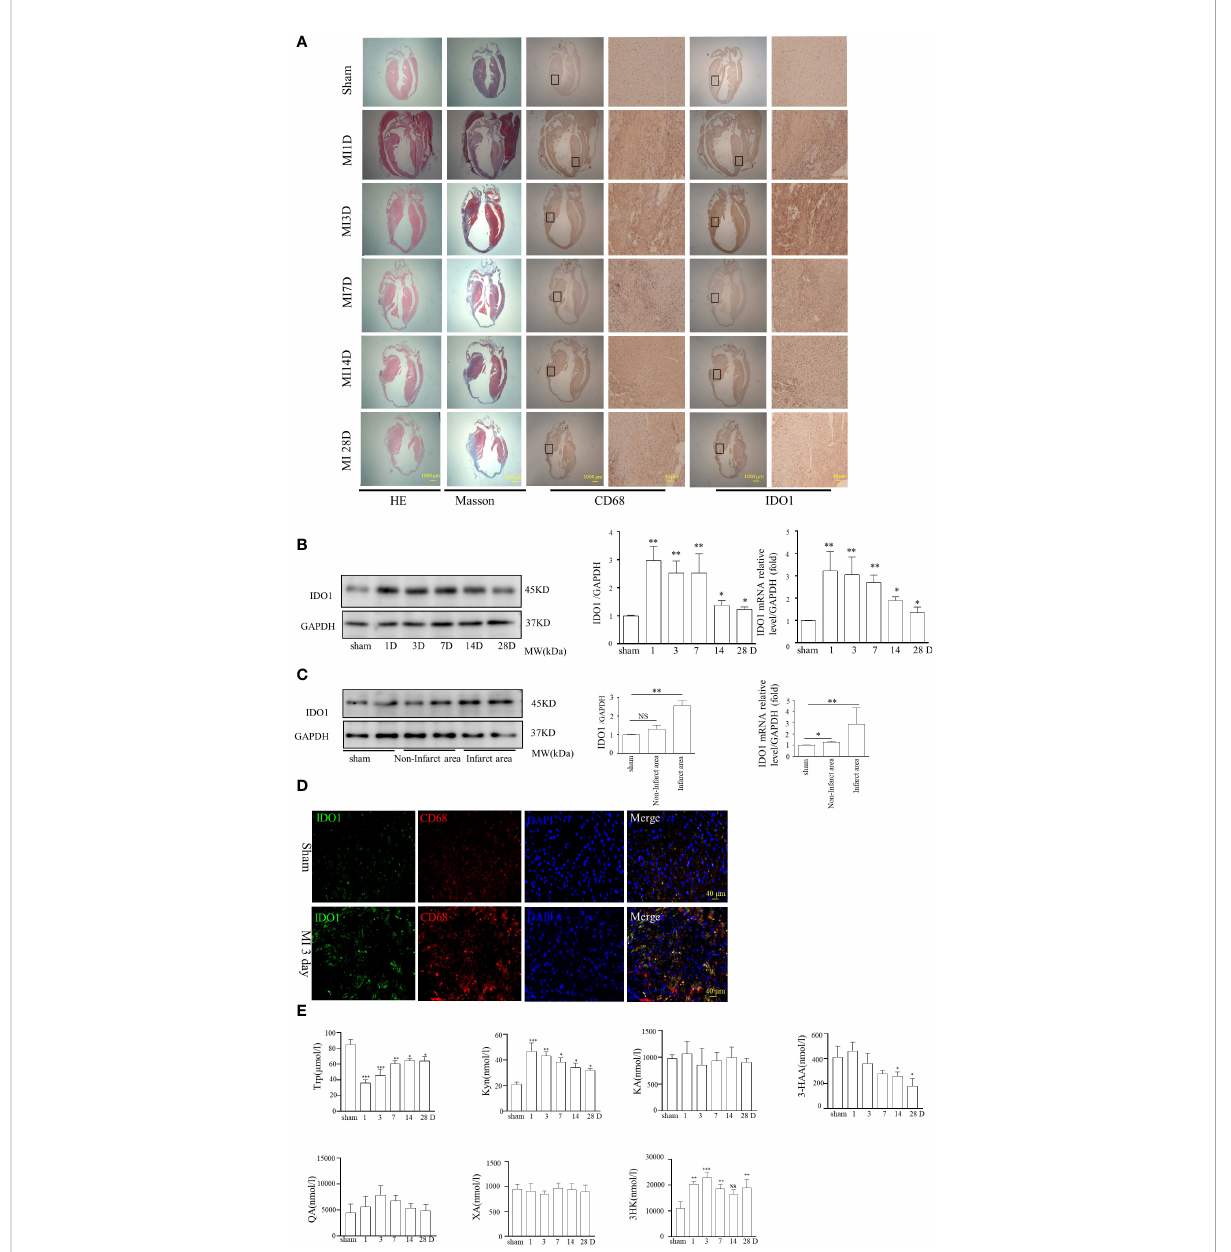
FIGURE 3 IDO1 expression in the cardiac macrophage cells and the plasma of mice remodeling after MI. (A) Induction of MI by the permanent ligations of the left anterior descending artery (MI) at 1d, 3d, 7d, 14d, and 28d points or sham operations without ligation were performed on the experimental animals as described previously. Immunohistochemical analyses showed that IDO1 and CD68 were co-localized in the infarct and non-infarct area at different time points after MI, indicating that IDO1 was highly expressed in macrophage cells especially during 1 − 3 days after MI (scale bar, 1000 m m, scale bar, 40 m m). (B) IDO1 expression in heart was determined at different time points after MI using western blot analysis, NS, not signi fi cant, *P<0.05 vs sham group, **P<0.01 vs sham group, n=3. (C) IDO1 expression in the infarct and non-infarct area after MI was showed in the western blot analysis, *P<0.05 vs sham group, **P<0.01 vs sham group, n=3. (D) The colocalization of IDO1 with CD68 demonstrated with immuno fl uorescence in macrophage cells. (E) Distribution of Trp metabolites between the sham and MI group at different time points. Trp, tryptophan; Kyn, kynurenine; 3-HK, 3-hydroxykynurenine; KA, kynurenic acid; XA, xanthurenic acid; 3-HAA, 3- hydroxyanthranilic acid, *P<0.05 vs sham group, **P<0.01 vs sham group,